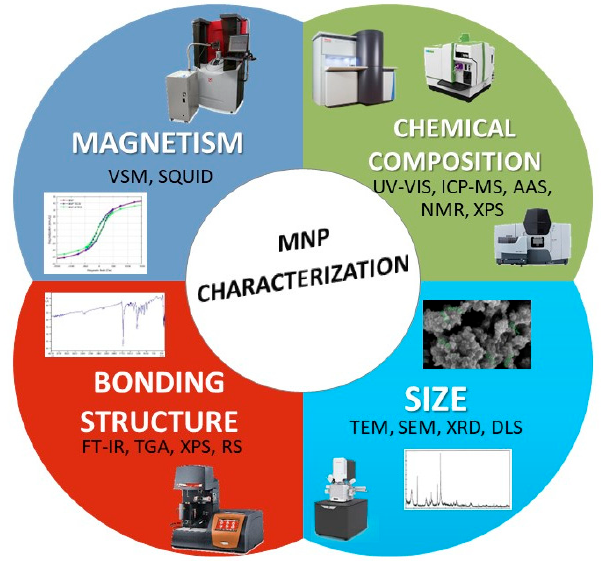
Figure 2. Characterization techniques for